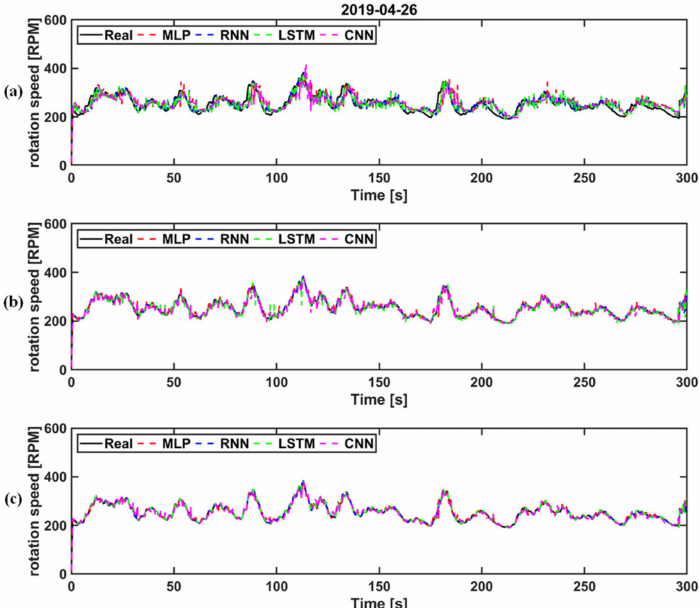
Figure 12. Comparison of prediction performance as a function of the number of input datasets for each algorithm (26 April 2019): ( a ) the two datasets with the highest correlation; ( b ) six datasets with high correlation; and ( c ) all training